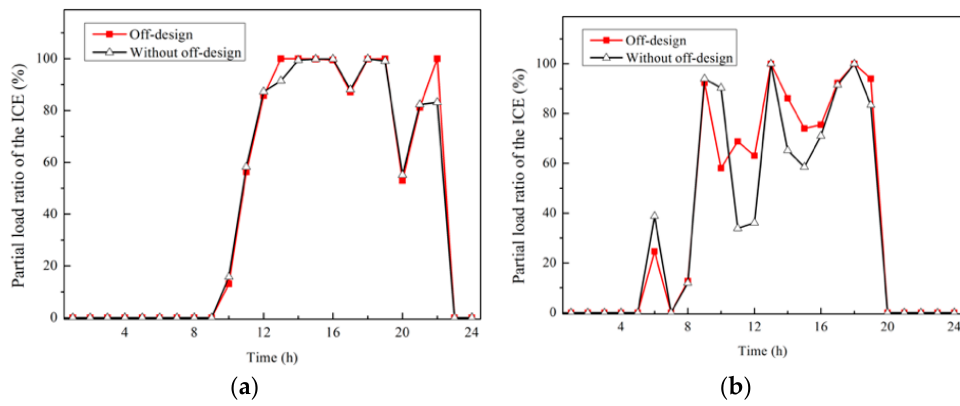
Figure 15. PLR of the ICE: ( a ) summer conditions; ( b ) winter conditions.